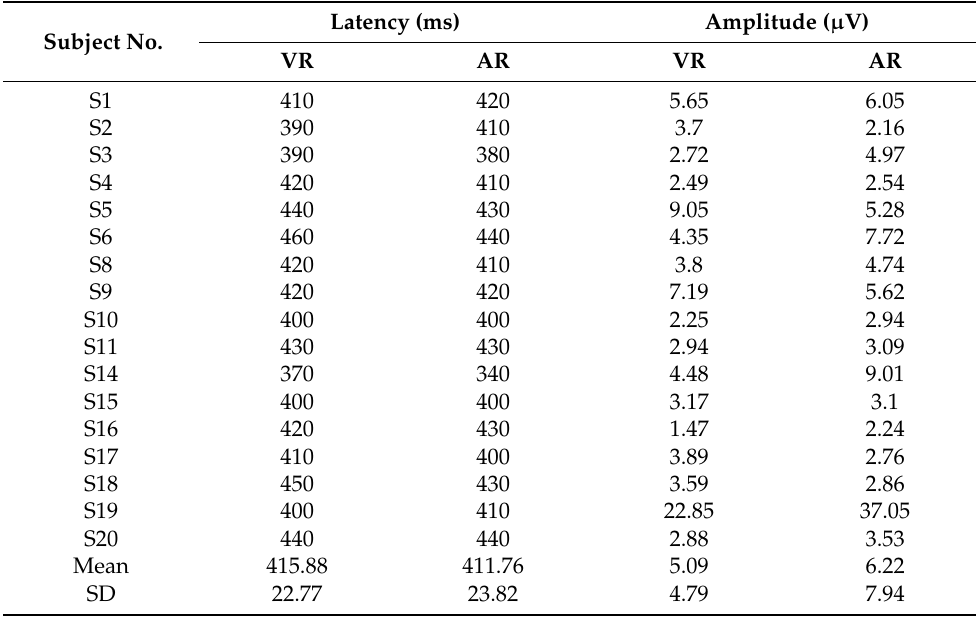
Table 4. Comparison of the ERP in VR and AR. Mean and standard deviation (SD) are presented at the bottom.